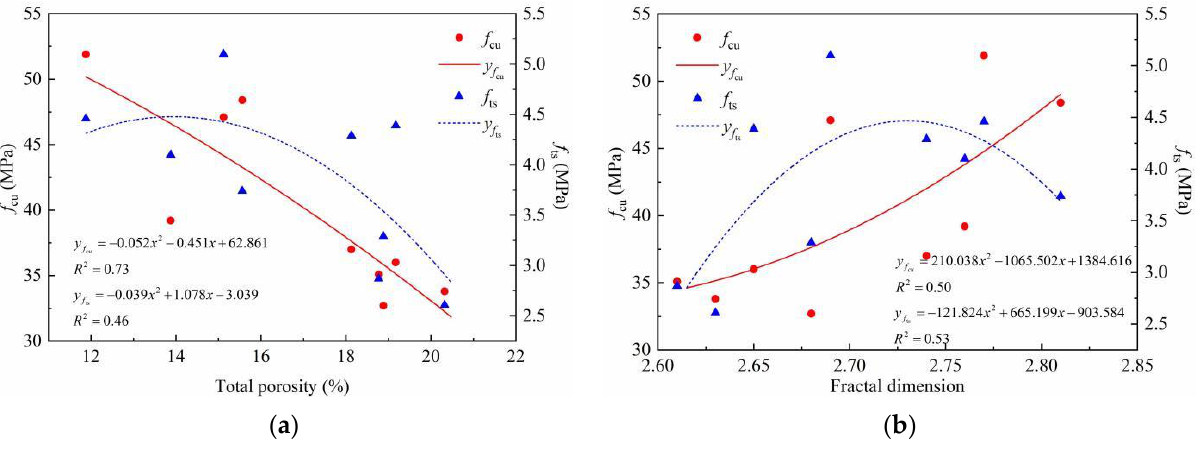
Figure 20. Fitting of SFRRC strength and pore characteristic parameters: ( a ) Total porosity fitting curve; ( b ) Fractal dimension fitting curve.